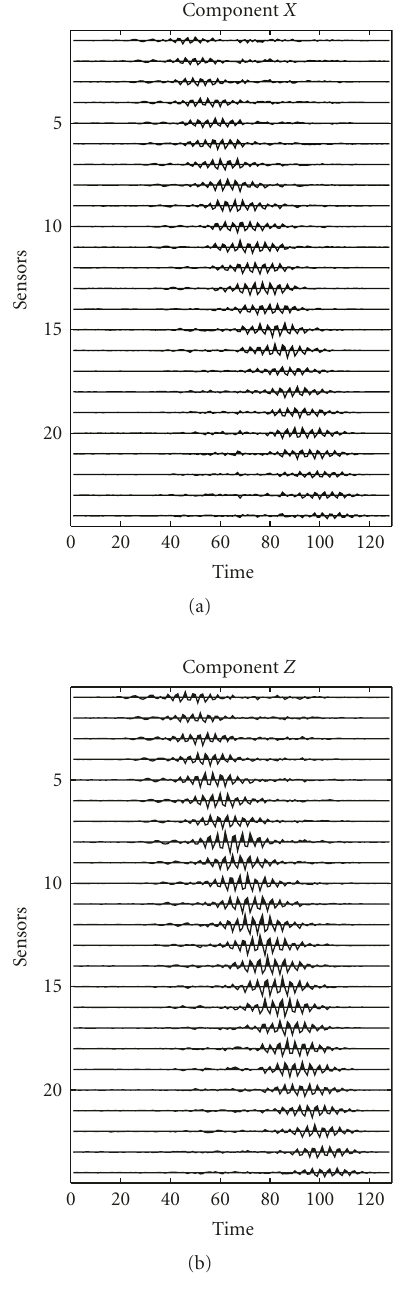
Figure 11: Second extracted wave after projecting initial dataset on the second eigenvector. (a) Component X , (b) Component